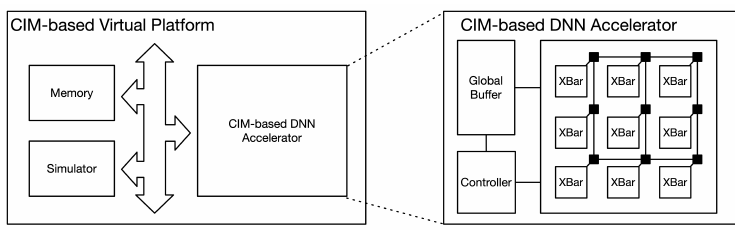
Figure 8. Virtual platform and CIM-based DNN